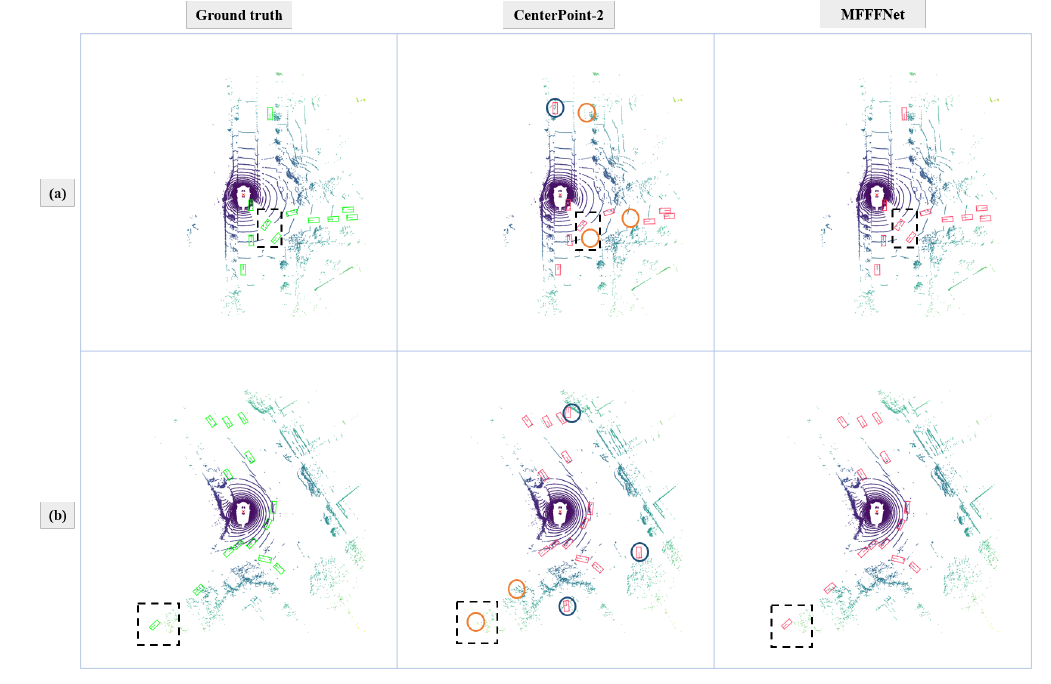
Figure 9. Comparison between MFFFNet and CenterPoint-2. Line ( a , b ) indicate two different scenes. The first column is the ground truth. The second and third columns are the detection results of the CenterPoint-2, and the MFFFNet, respectively. The green box represents the ground truth. The red box indicates the test results. The black dashed box indicates the areas that need to be focused on. Blue and orange circles indicate false positive and false negative results.